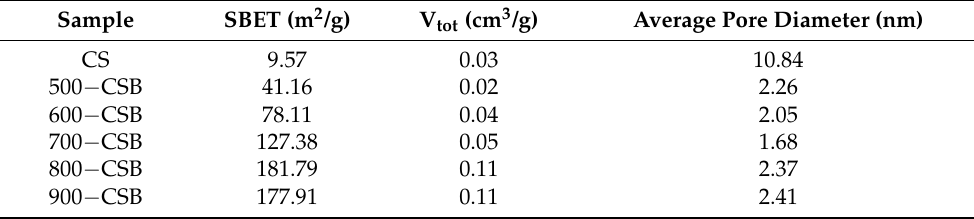
Table 1. BET parameters of crab shell biochar at different pyrolysis temperatures.